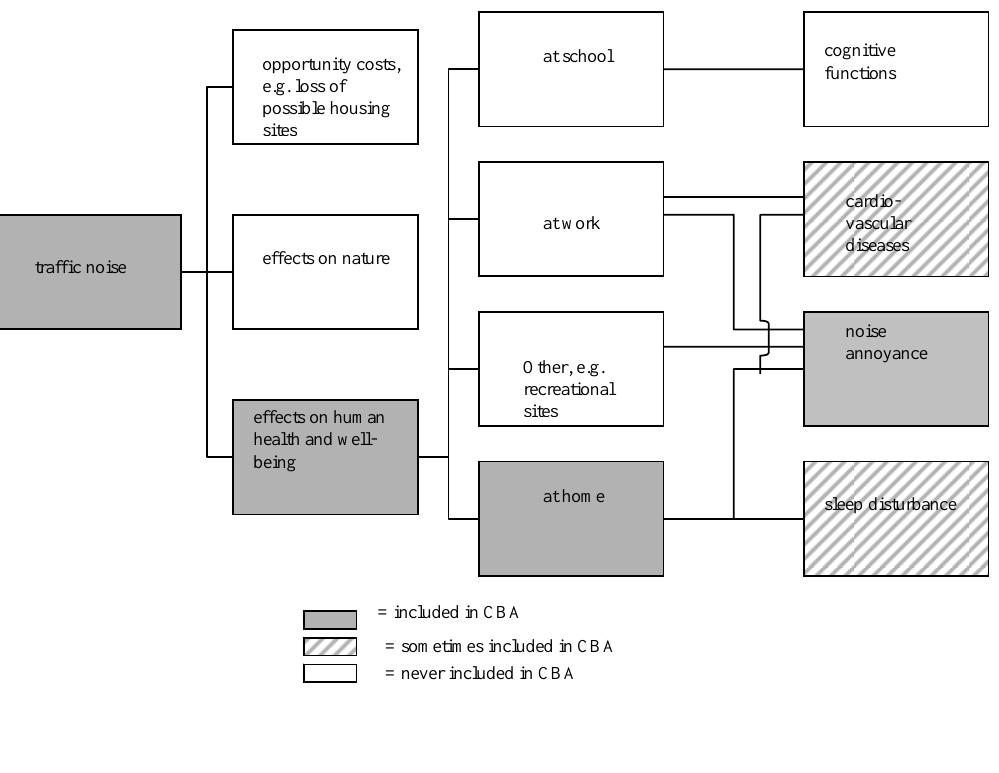
Figure 3. Conceptual model of transport noise